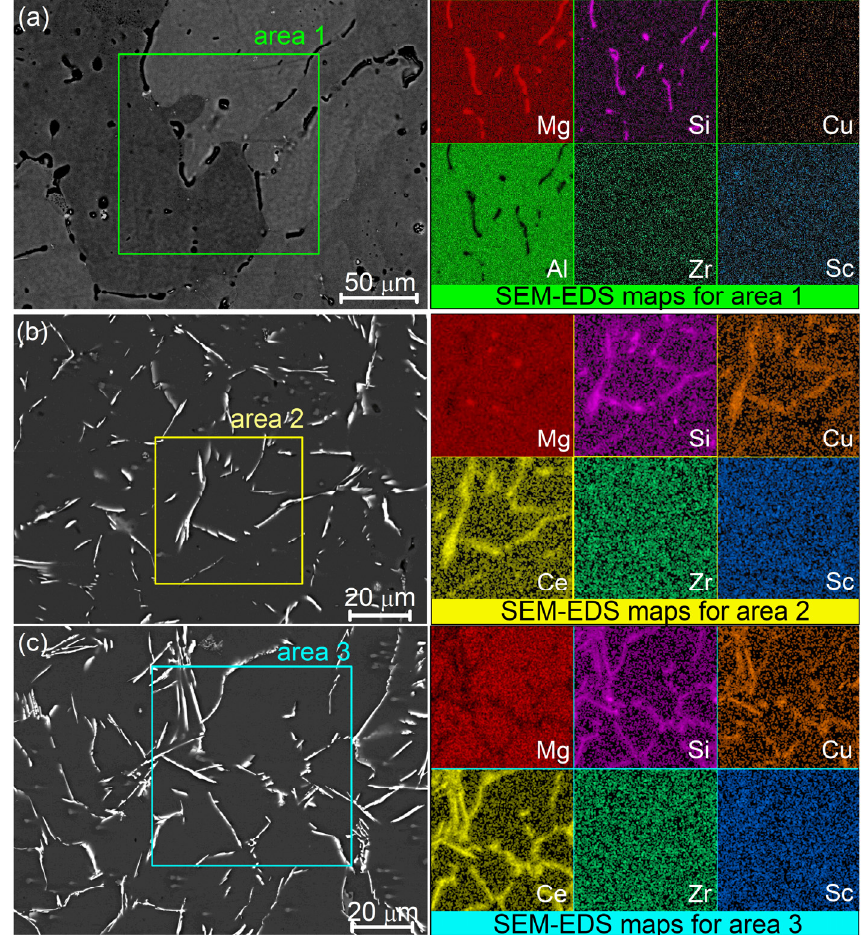
Figure 2. SEM-BSE micrographs and corresponded SEN-EDS maps for ( a ) 0Ce, ( b ) 2Ce, and ( c ) 4Ce alloys after a two-step homogenization.